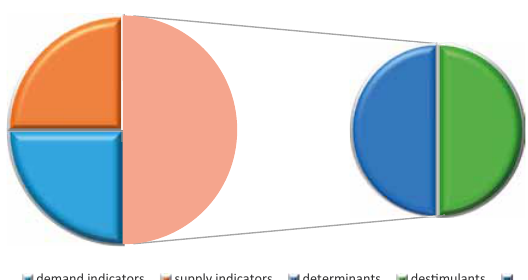
Fig. 5. Contribution of rating attributes toolkit in the real estate market rating model Source : own